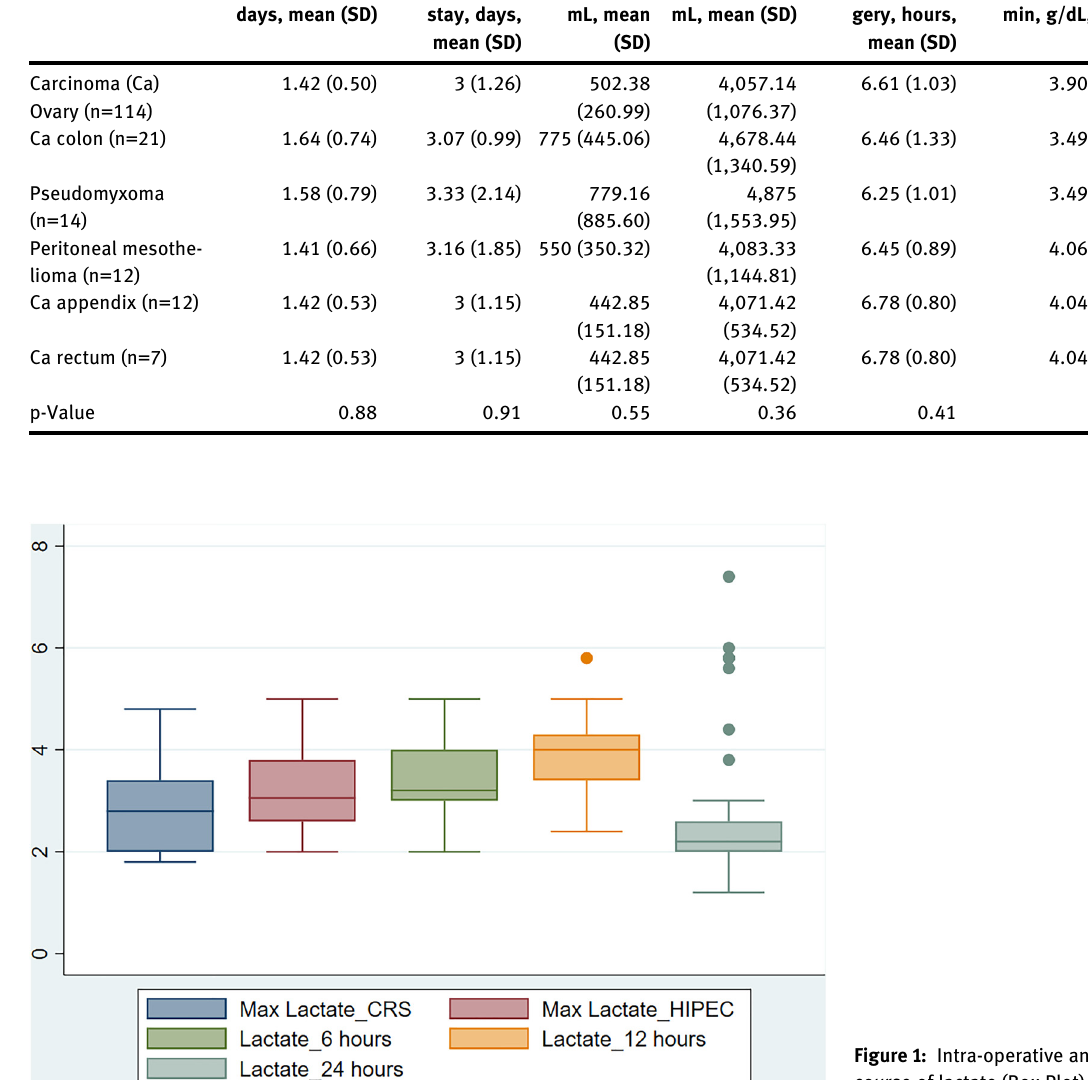
Table  : Peri-operative variables of patients undergoing CRS/HIPEC (n=  ). Diagnosis Day of